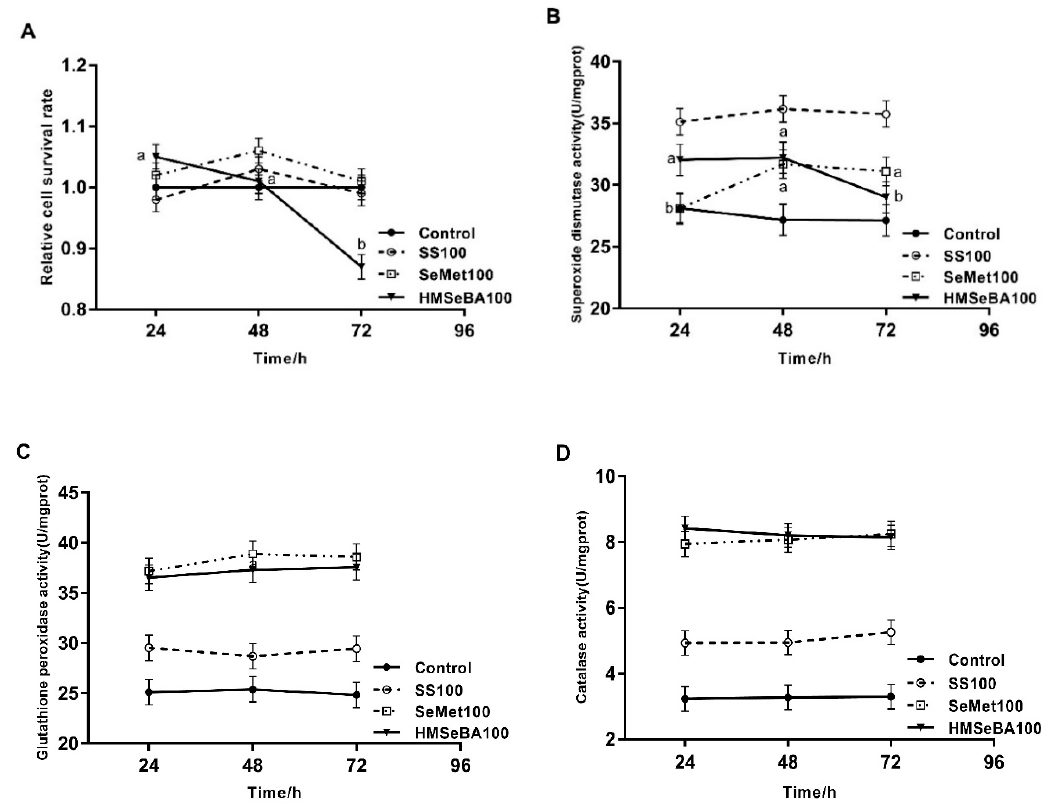
Figure 1. Effect of culture time with different Se sources on cell survival rate ( A ), SOD activity ( B ), GSH-Px activity ( C ) and CAT activity ( D ) of BMEC. All values shown are mean ± SEM from three independent experiments. Different letters in the same Se treatment denote significant differences among culture time.